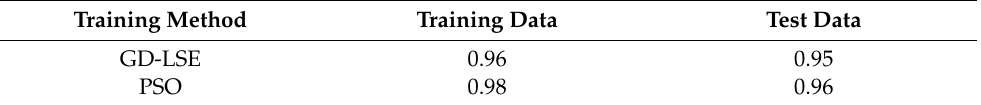
Table 6. Summary of R coefficients obtained for the evaporator outlet pressure